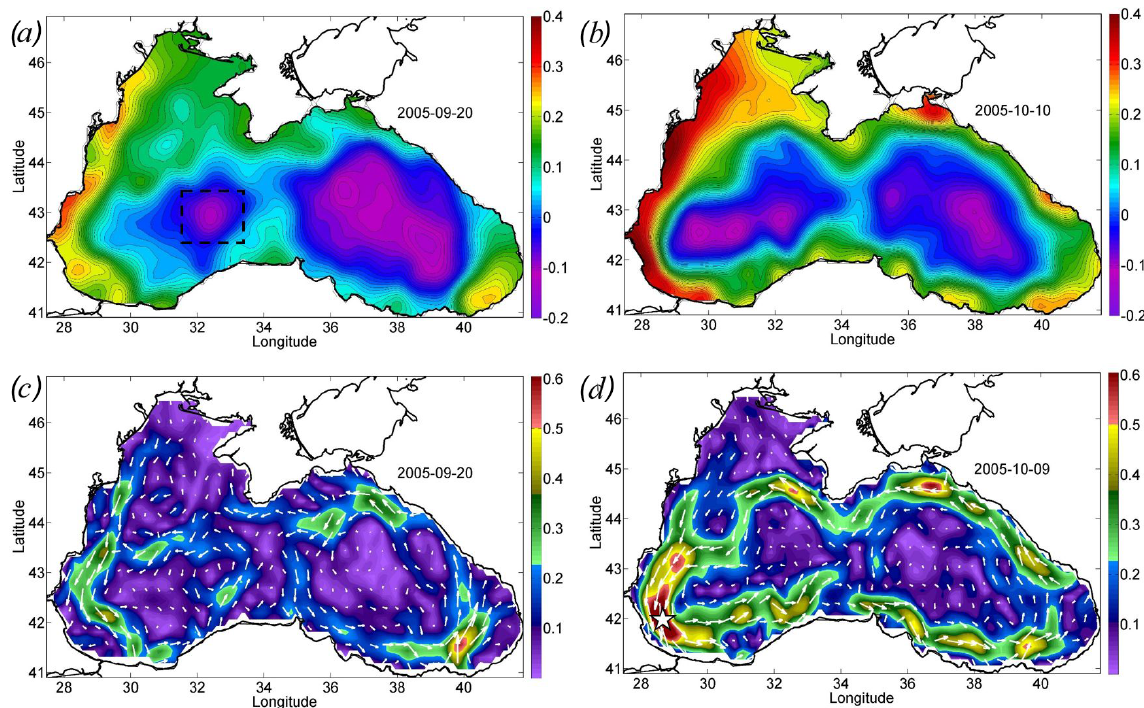
Figure 2. Altimetry-derived map of sea level and geostrophic velocity before (a, c) and after (b, d) the action of the cyclone. Sea level (meters) on (a) 20 September 2005 and (b) 10 October 2005. Geostrophic velocity (meters per second) on (c) 20 September 2005 and (d) 9 October 2005. The black rectangle in panel (a) shows the position of the western cyclonic gyre. Velocity magnitude (c, d) is shown by color scale.